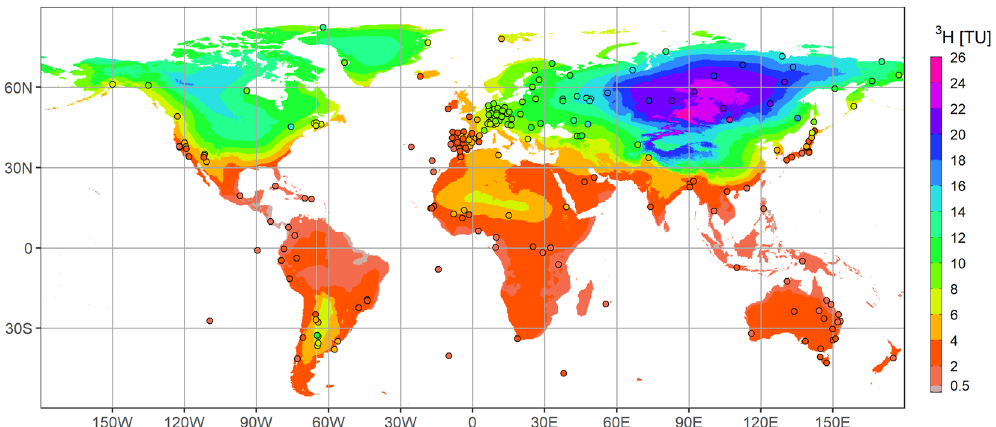
Figure 1. Global patterns of 3 H in precipitation. Model gridded and measured contemporary (2008–2018) 3 H contents in Earth’s precipitation at GNIP stations (circles). The tritium distribution map (“isoscape”)